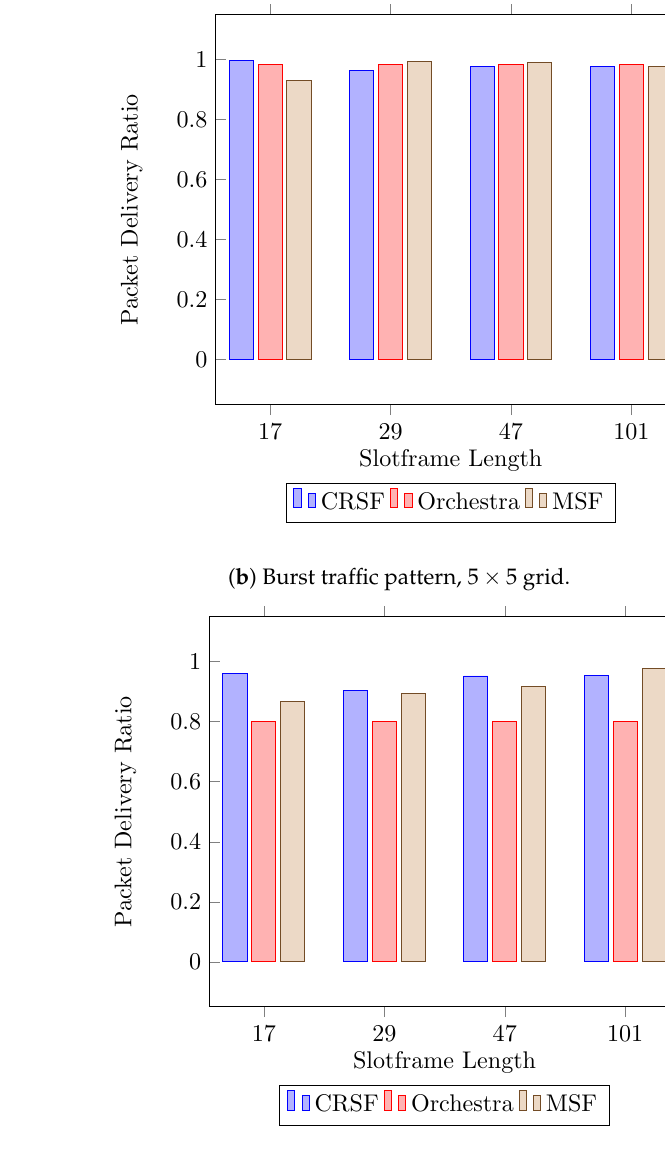
( b ) Burst traffic pattern, 5 × 5 grid.